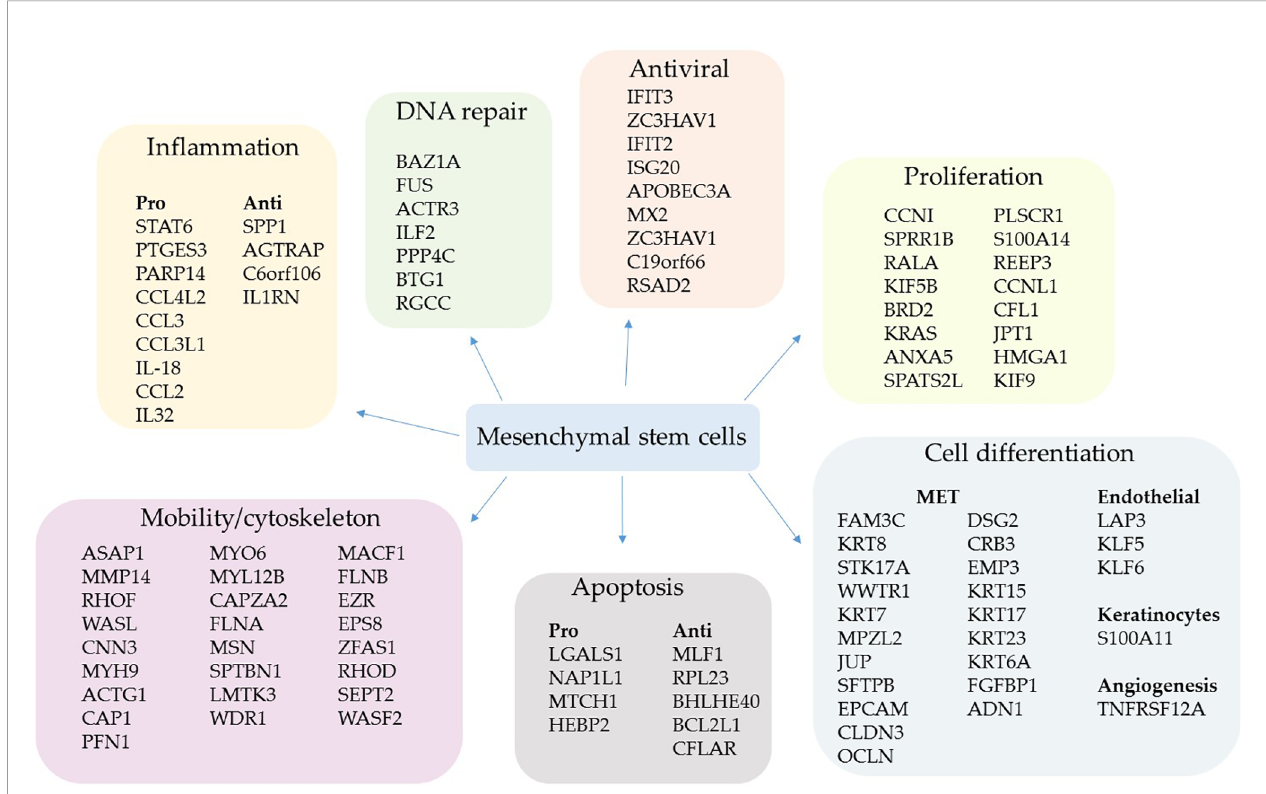
FIGURE 2 | Upregulated genes grouped by biological function in severe cases. The comparative analysis of MSCs ’ transcripts from COVID-19 patients with severe over patients with mild symptoms yielded the identi fi cation of upregulated genes in critically ill individuals. The MSCs were analyzed in BAL fl uid, and the genes were grouped according to their biological